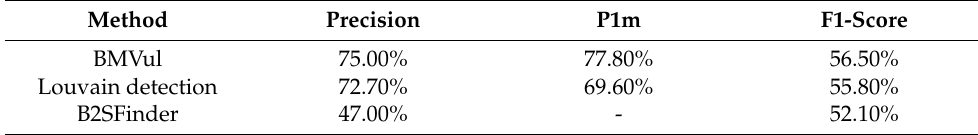
Table 5. Comparison of BMVul with other methods in terms of